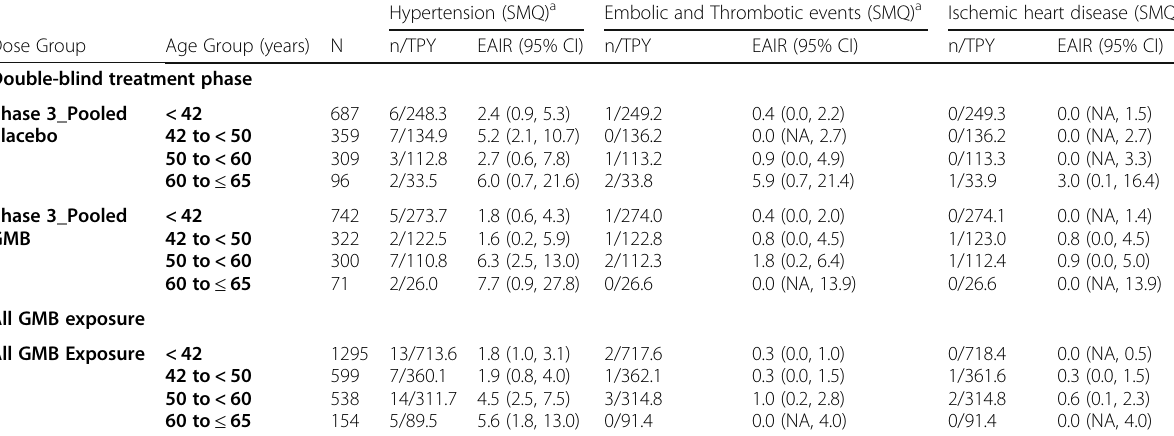
Table 5 Treatment-emergent adverse events likely to be cardiovascular in